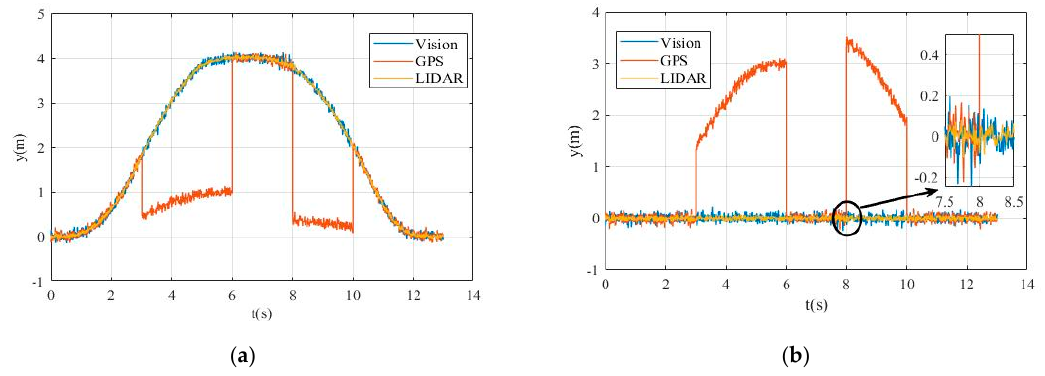
Figure 8. The lateral position changes in simulation: ( a ) lateral position detected by using different sensors; and ( b ) the lateral position error.